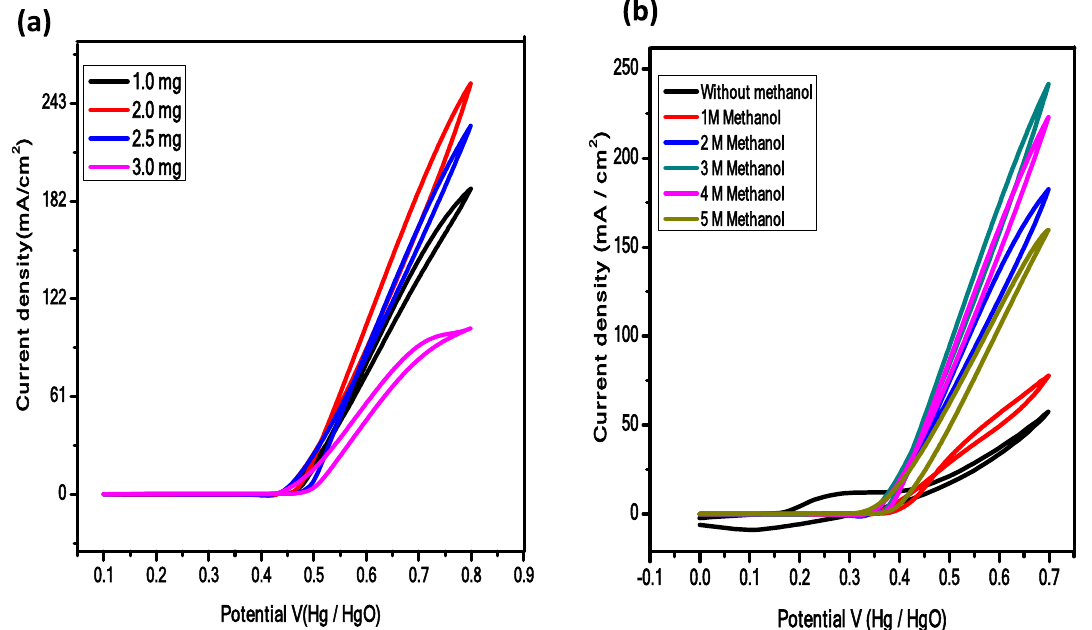
Figure 7. ( a ) Influence of electrocatalyst deposited quantity, and ( b ) CH 3 OH molarity on the current density response of NiNH 2 BDC MOF/1, 2, 5 wt% reduced graphitic carbon hybrids during the optimization